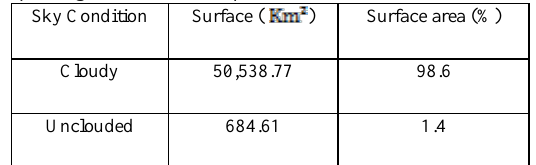
Figure 21 : Cloud coverage concluded from placing threshold (April 20 th ) Table 4: The surface of area under various conditions derived from placing thresholds on April 20 th